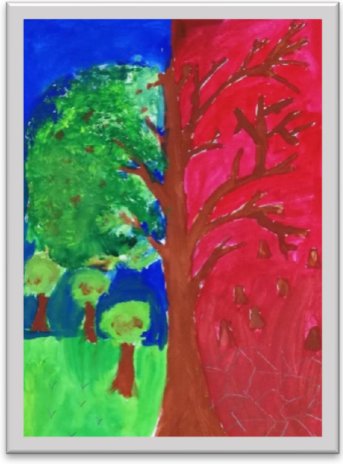
Figure 4. Student’s future of place drawing .